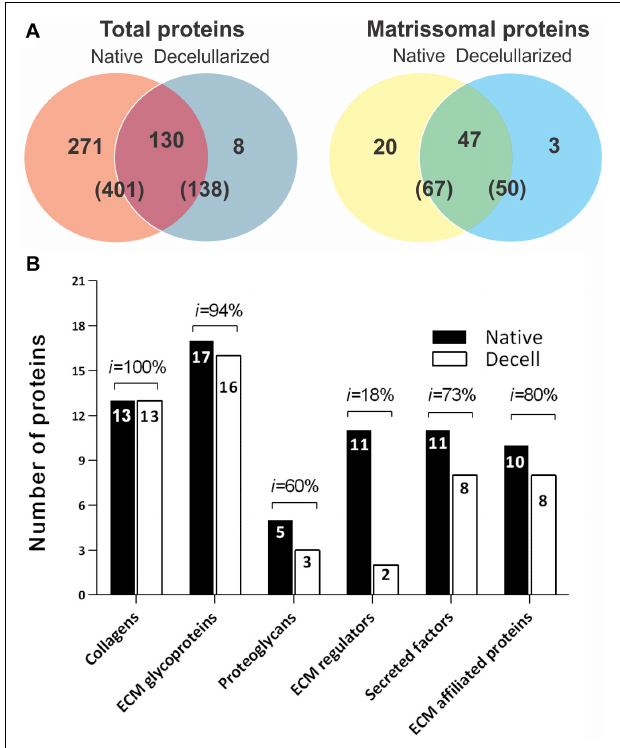
FIGURE 4 | Cellular and matrisomal content before and after the spleen decellularization process. (A) Venn diagram showing the amount of total and matrix proteins shared between native and decellularized tissues. (B) Bar graph showing the number of proteins and the percentage maintenance rate ( i ) by class between native and decellularized tissues. The results are represented as the percentage of the total number of proteins and in parentheses, as the number of proteins for each